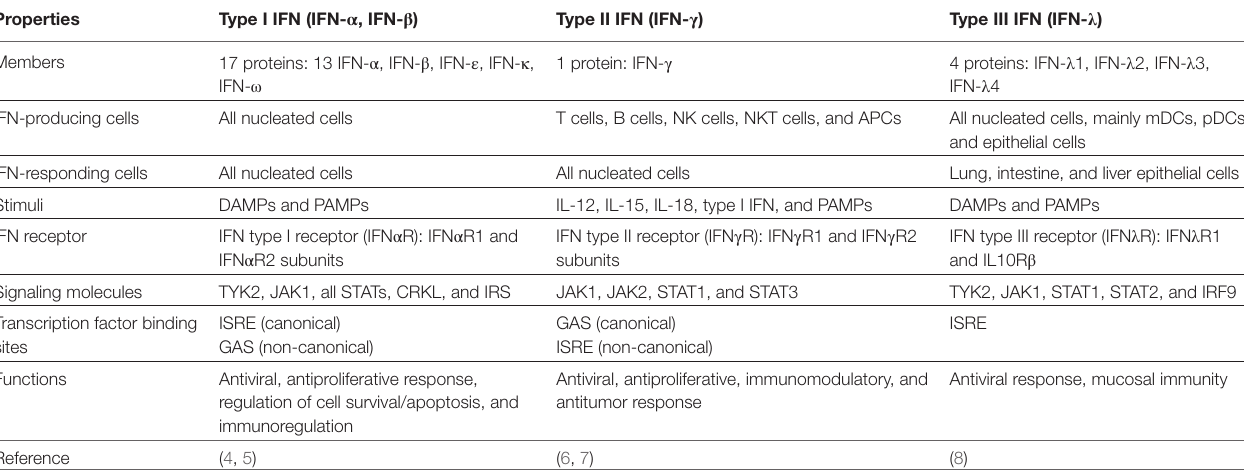
Table 1 | Comparison of human type I, type II, and type III IFN production and signaling.